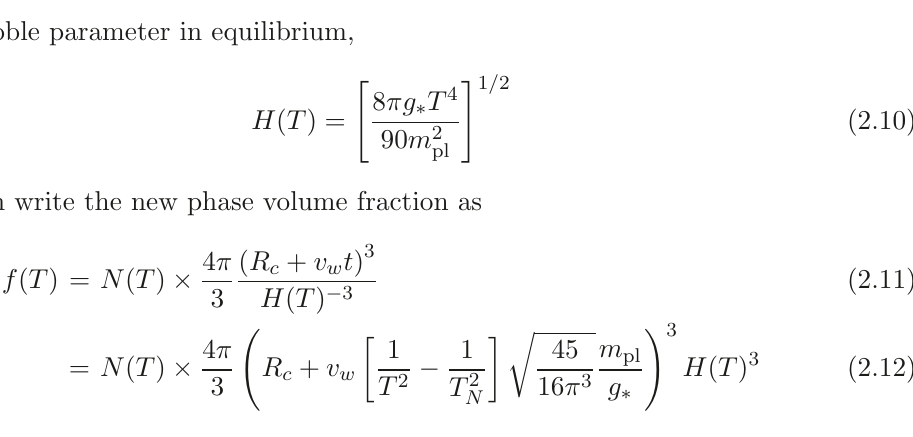
Figure 1 . Benchmark example for the volume fraction (2.11) as a function of temperature. For this benchmark, T c = 196 GeV and v ( T c ) = 225